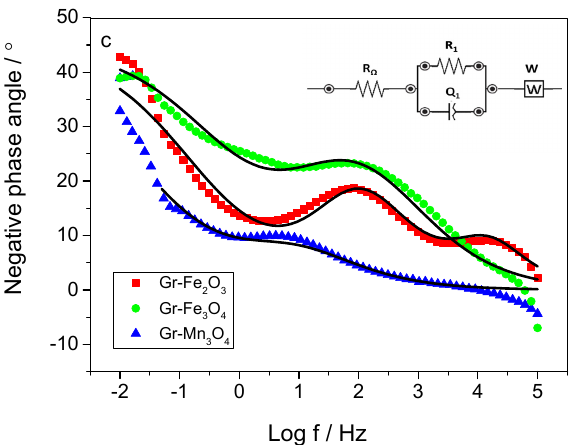
Figure 5. Electrochemical behavior of the fabricated materials in the presence of Pseudomonas putida 1046: ( a ) cyclic voltammograms obtained on the 5th day, inset—non-modified graphite; ( b ) Nyquist and ( c ) Bode plots of the EIS, respectively, carried out on the 10 th day of cultivation, E dc = +100 mV; measured data-scatters, fitted data-lines. The impedance spectra of the investigated materials in the presence of bacteria are presented as Nyquist and Bode plots in Figure 5b,c, and the impedance parameters, derived from the fitted spectra, are summarized in Table 1. The experimental EIS data fit well to the equivalent circuit models